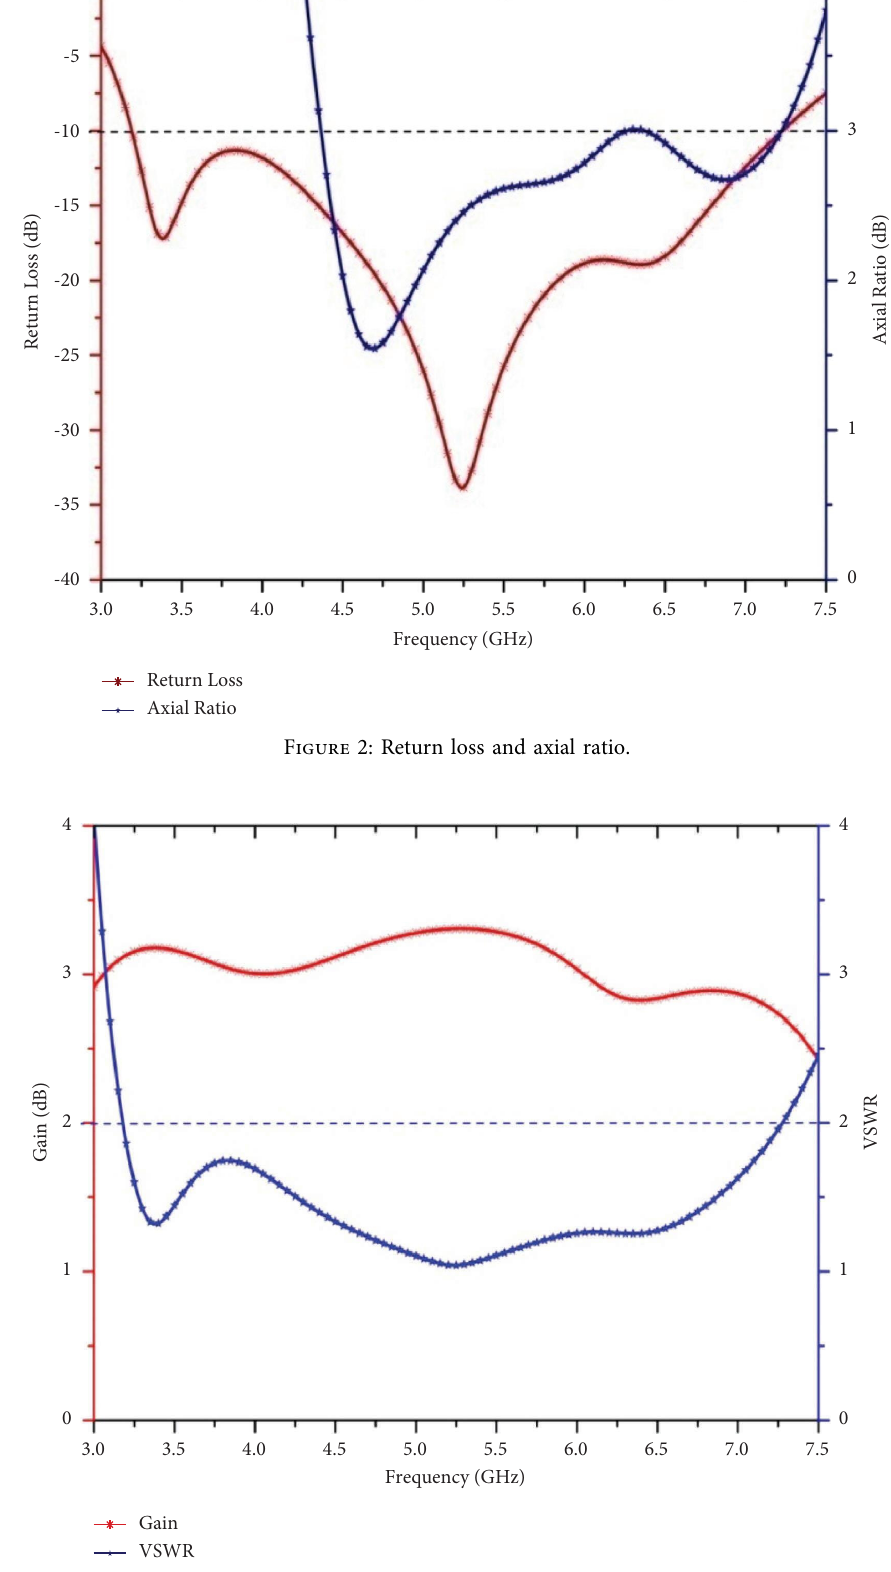
Figure 3: Gain and